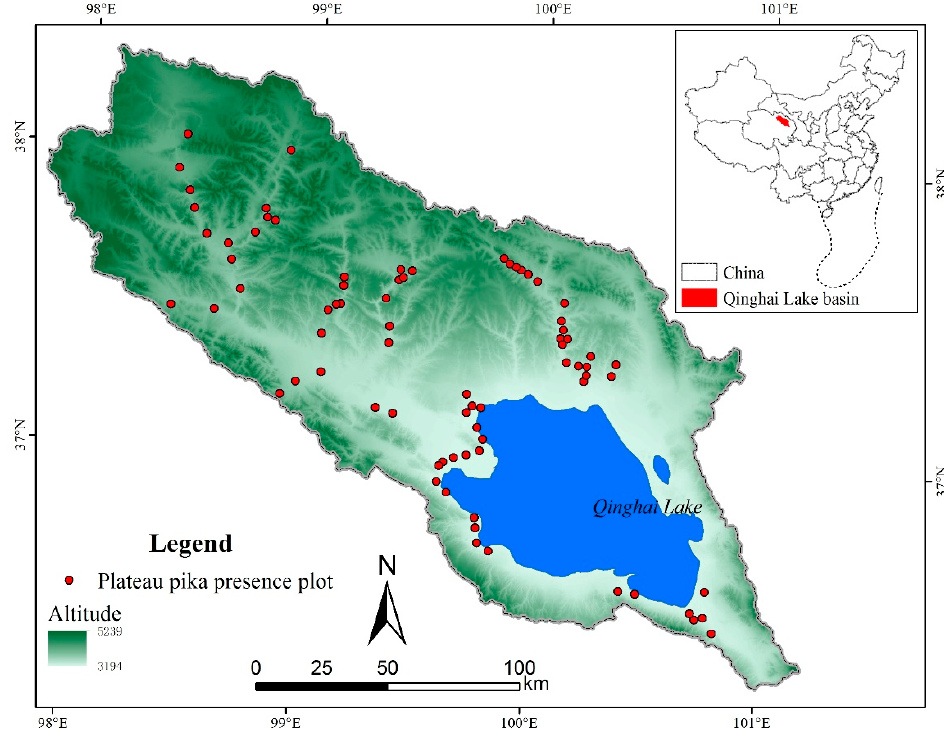
Figure 1. Location of the Qinghai Lake basin and sampling plots of the plateau pika’s distribution.